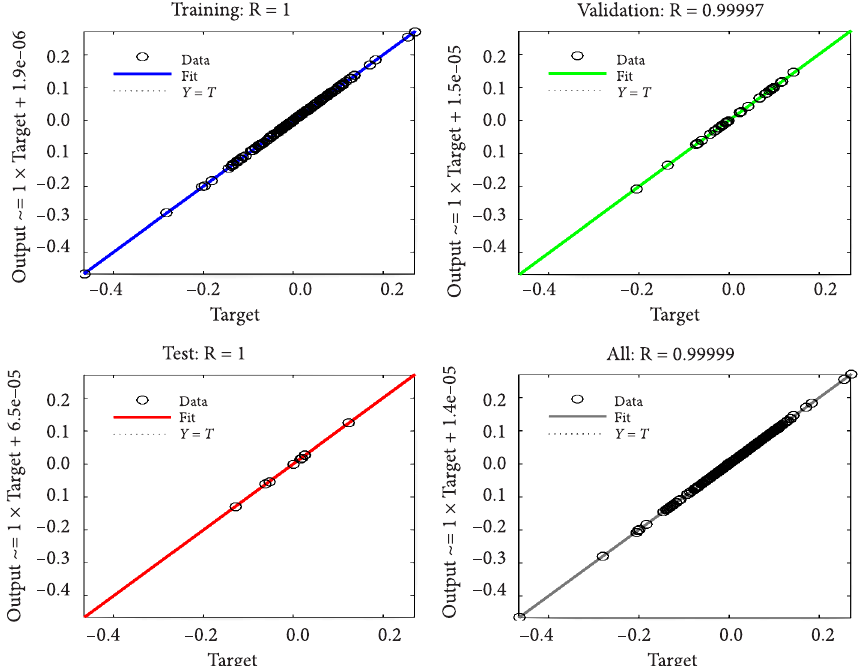
Figure 2. FF5F based Regression Analysis for Mid Beta Portfolios